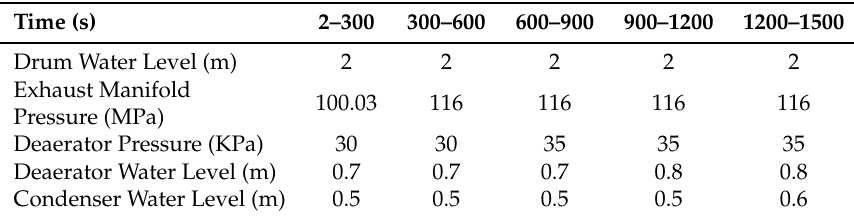
Table 3. Setpoints for different loops in the experiments.